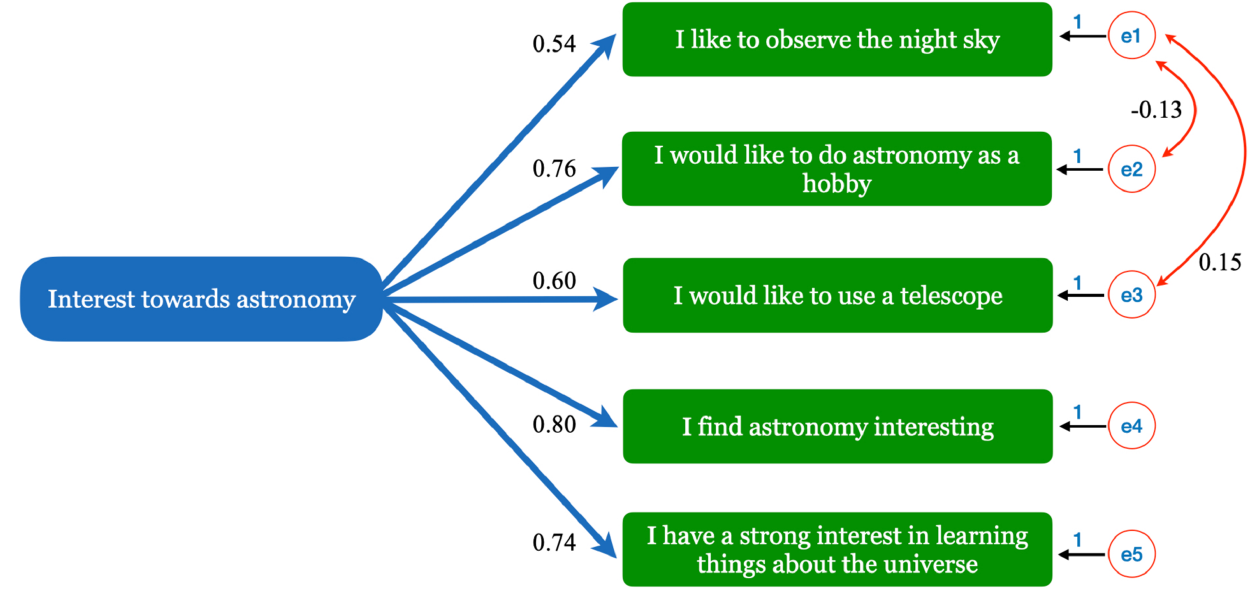
FIG. 2. Factor structure of the interest towards astronomy scale ( N ¼ 805 ). Regression weights are standardized. Each arrow with the line connecting two variables in the diagram indicates the direction of regression. Two headed arrows represent the residual correlations of the items.